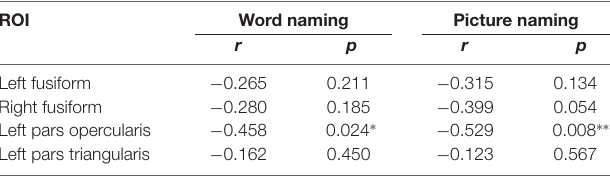
ROI Word naming Picture naming